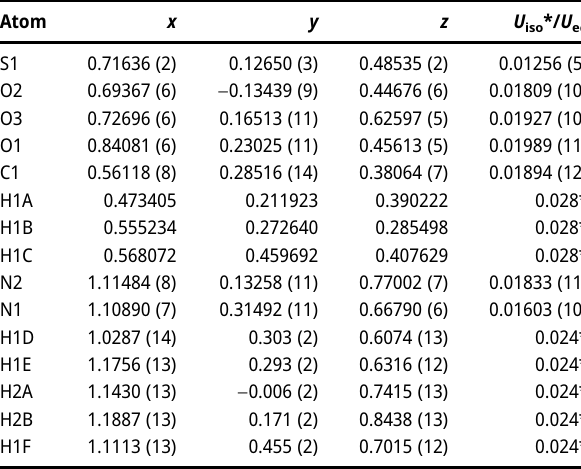
Table  : Fractional atomic coordinates and isotropic or equivalent isotropic displacement parameters (Å 